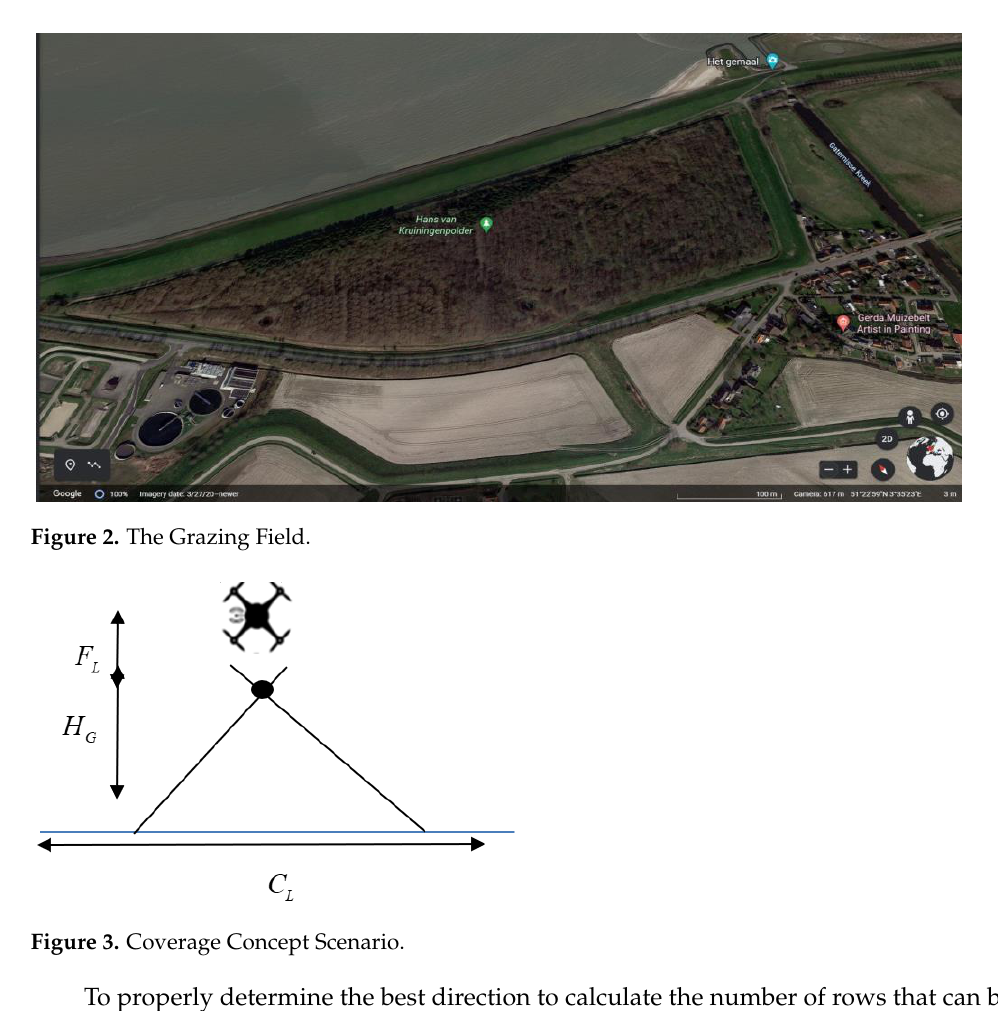
Figure 3. Coverage Concept Scenario.